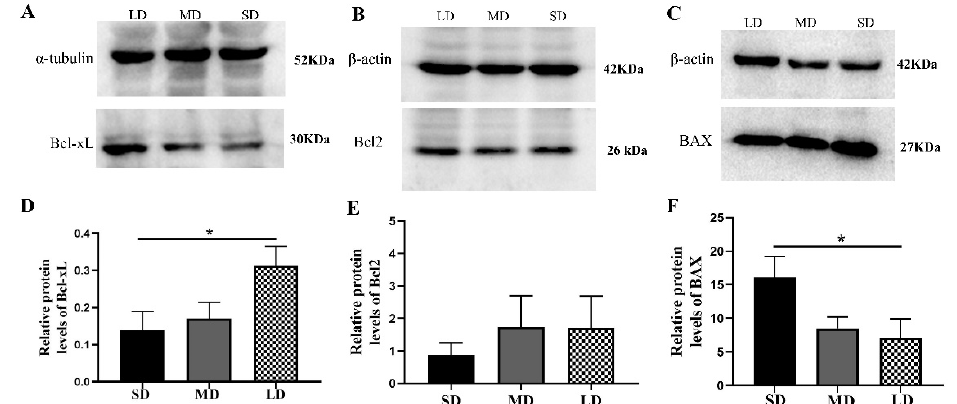
Figure 10. Levels of the B-cell lymphoma-2 (BCL-2) family protein expression in the ovaries of Phodopus sungorus under three photoperiod conditions. ( A – C ) Representative immunoblots of the key Bcl-xL, Bcl2, and BAX proteins and internal reference proteins ( α -tubulin and β -actin). ( D – F ) Relative protein expression of Bcl-xL, Bcl2, and BAX. Values are means ± SEM. n = 8. SD, short daylight; MD, moderate daylight; LD, long daylight. * p < 0.05.